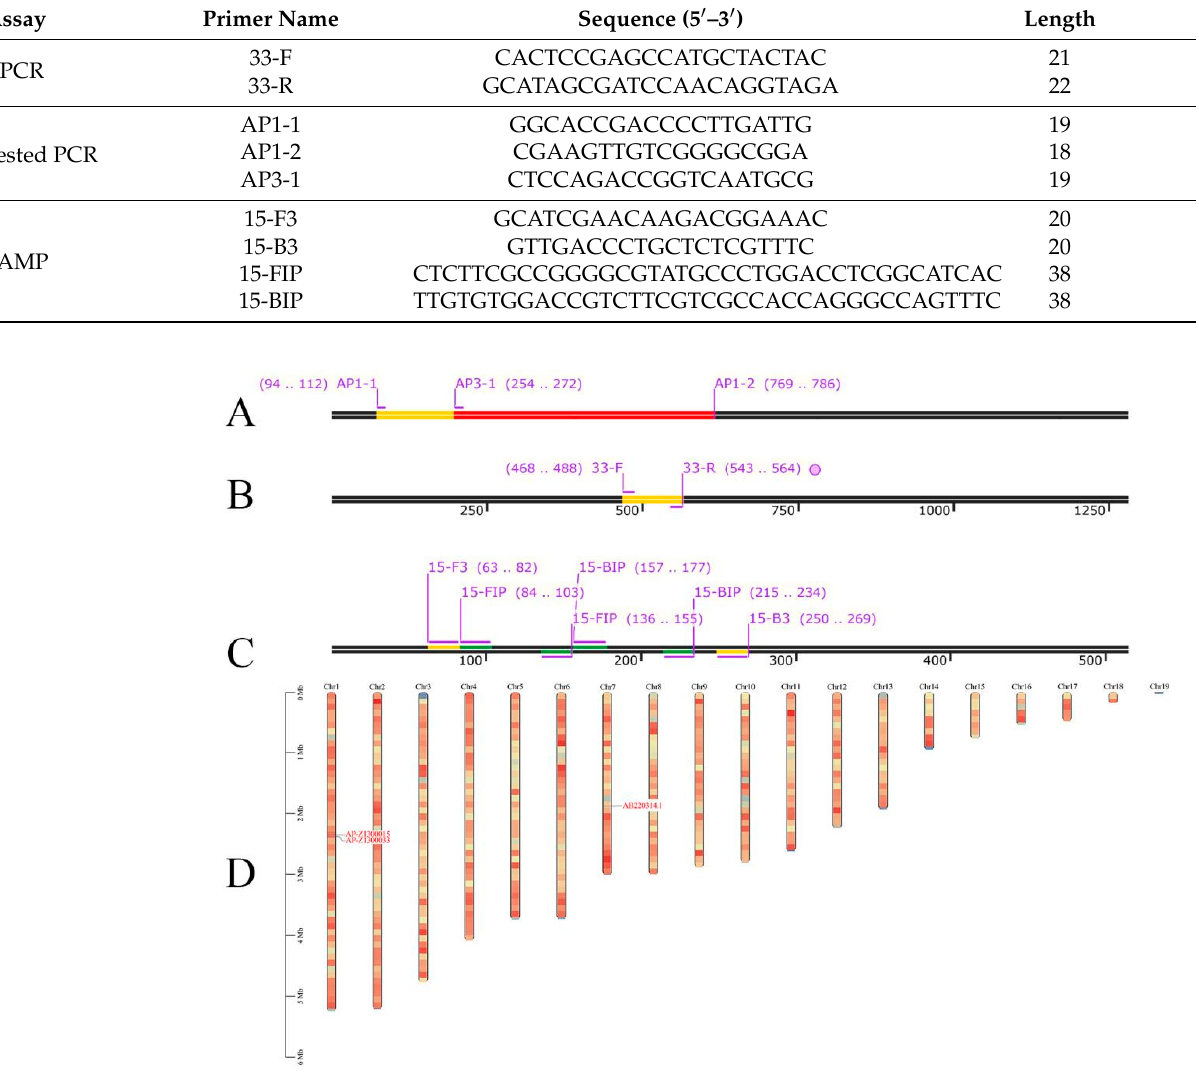
Table 2. Primer sequences of seminested PCR, qPCR, and LAMP for A. phaeospermum detection.